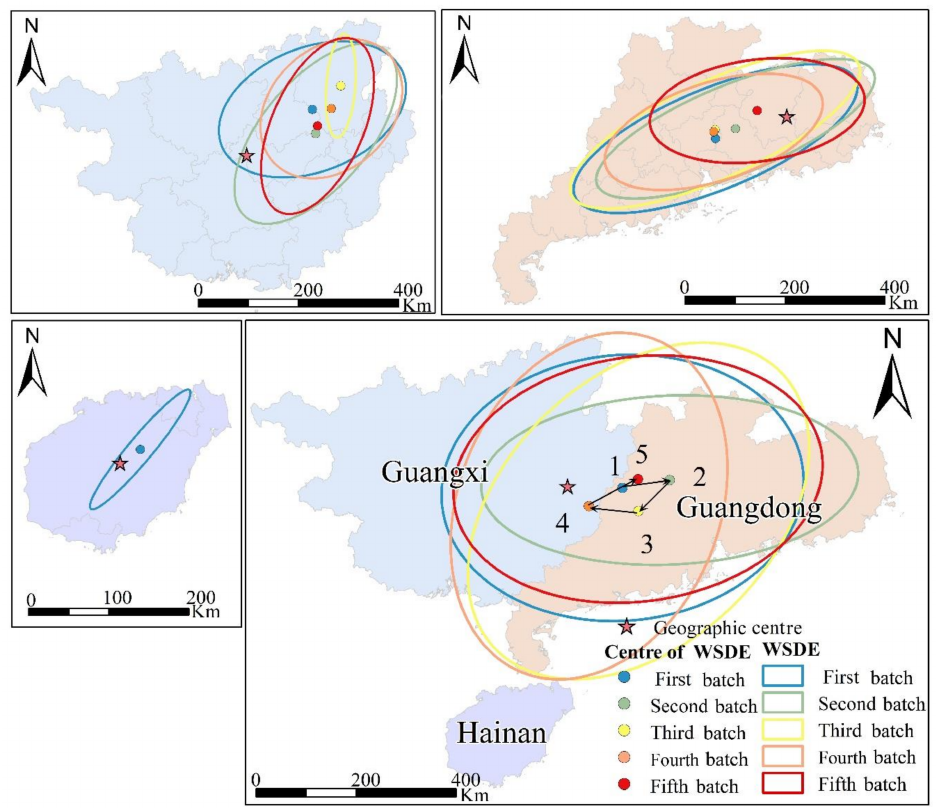
Figure 9. The WSDE and the center trajectories for southern China and subordinate provinces.